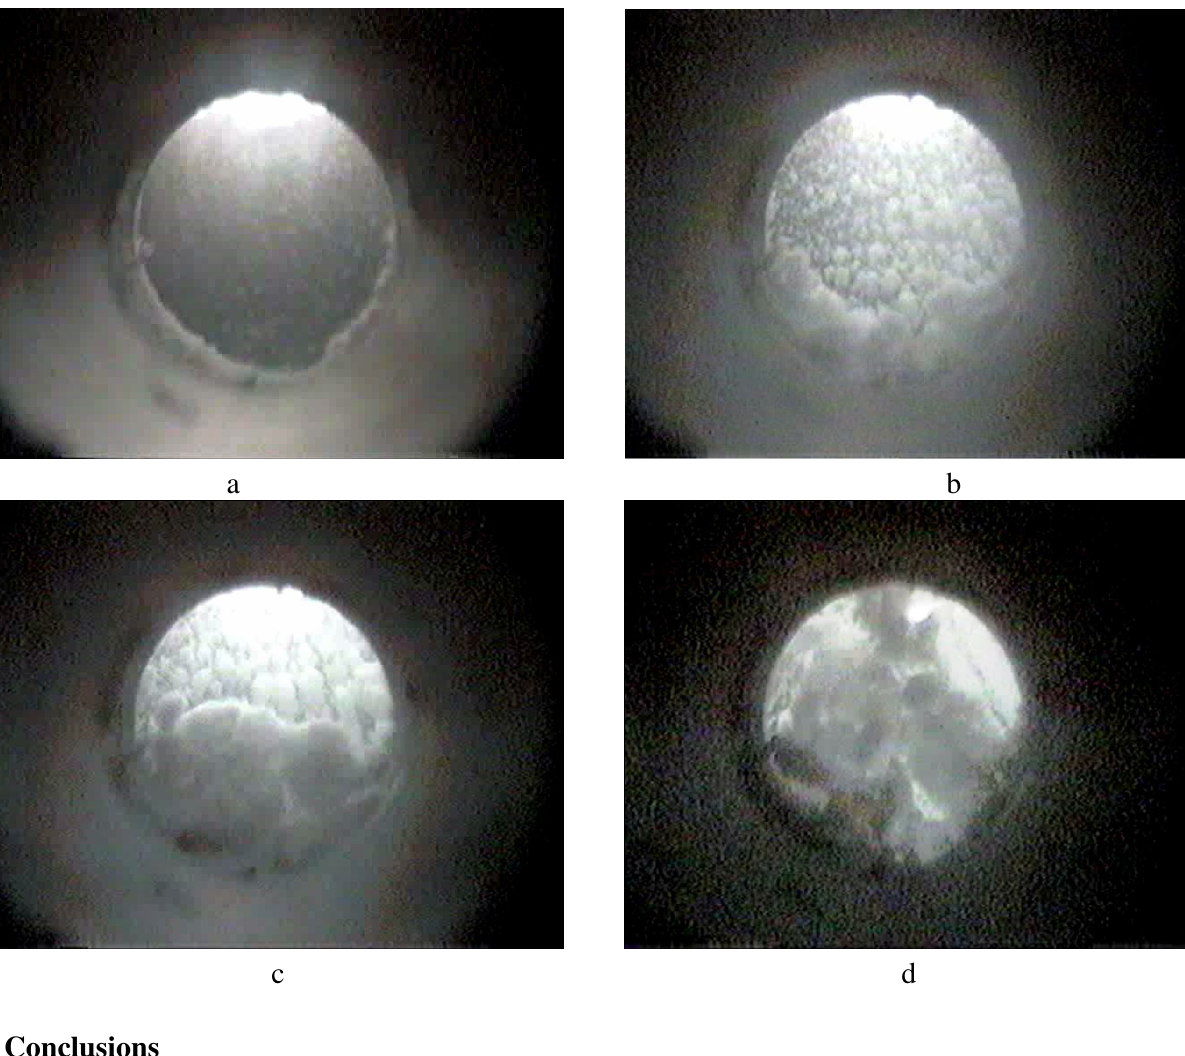
14. (a) Typical hydrate spray and subsequent hydrate deposition within NETL 15-Liter Hydrate Cell two (2) minutes into experiment–Camera 3 CL in Figure 10, above; (b) Typical hydrate spray and subsequent hydrate deposition within NETL 15-Liter Hydrate Cell ten (10) minutes into experiment–Camera 3 CL in Figure 10, above; (c) Typical hydrate spray and subsequent hydrate deposition within NETL 15-Liter Hydrate Cell fifteen (15) minutes into experiment–Camera 3 CL Figure 10, above; (d) Typical hydrate spray and subsequent hydrate deposition within NETL 15-Liter Hydrate Cell twenty-five (25) minutes into experiment–Camera 3 CL in Figure 10,